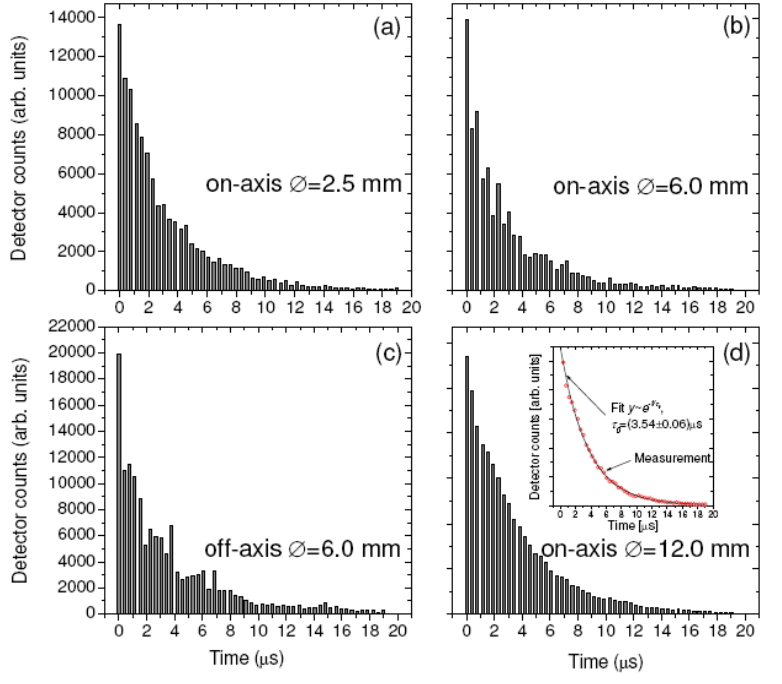
Figure 4. The effect of the transverse modes beating within 13 nm optical bandwidth (720–733 nm) for various scenarios of cavity excitation. (a) , (b) , (d) on- and (c) off-axis excitation. Inset of figure (d) additionally shows single exponential curve fitted to the data. Note different diameters of the exciting beam that are indicated on each of the